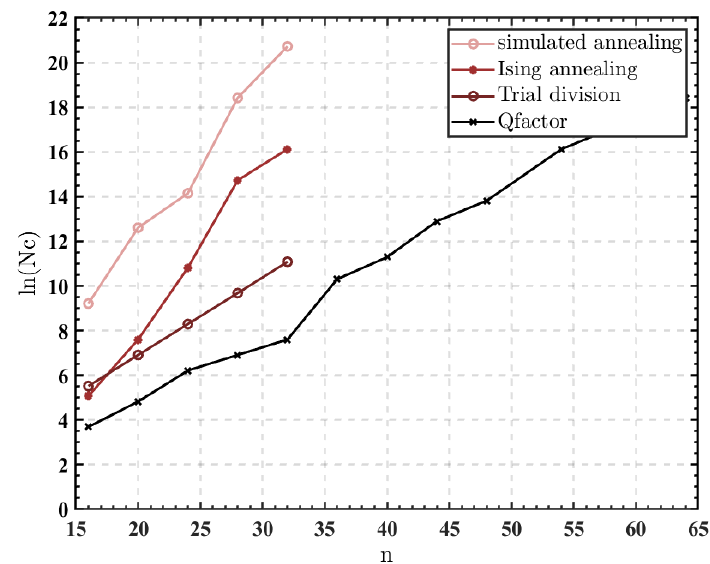
Figure 8. The required cycles to factor n -bit integers. Nc in the Y axis represents the number of required cycles. The four algorithms are simulated using MATLAB software.